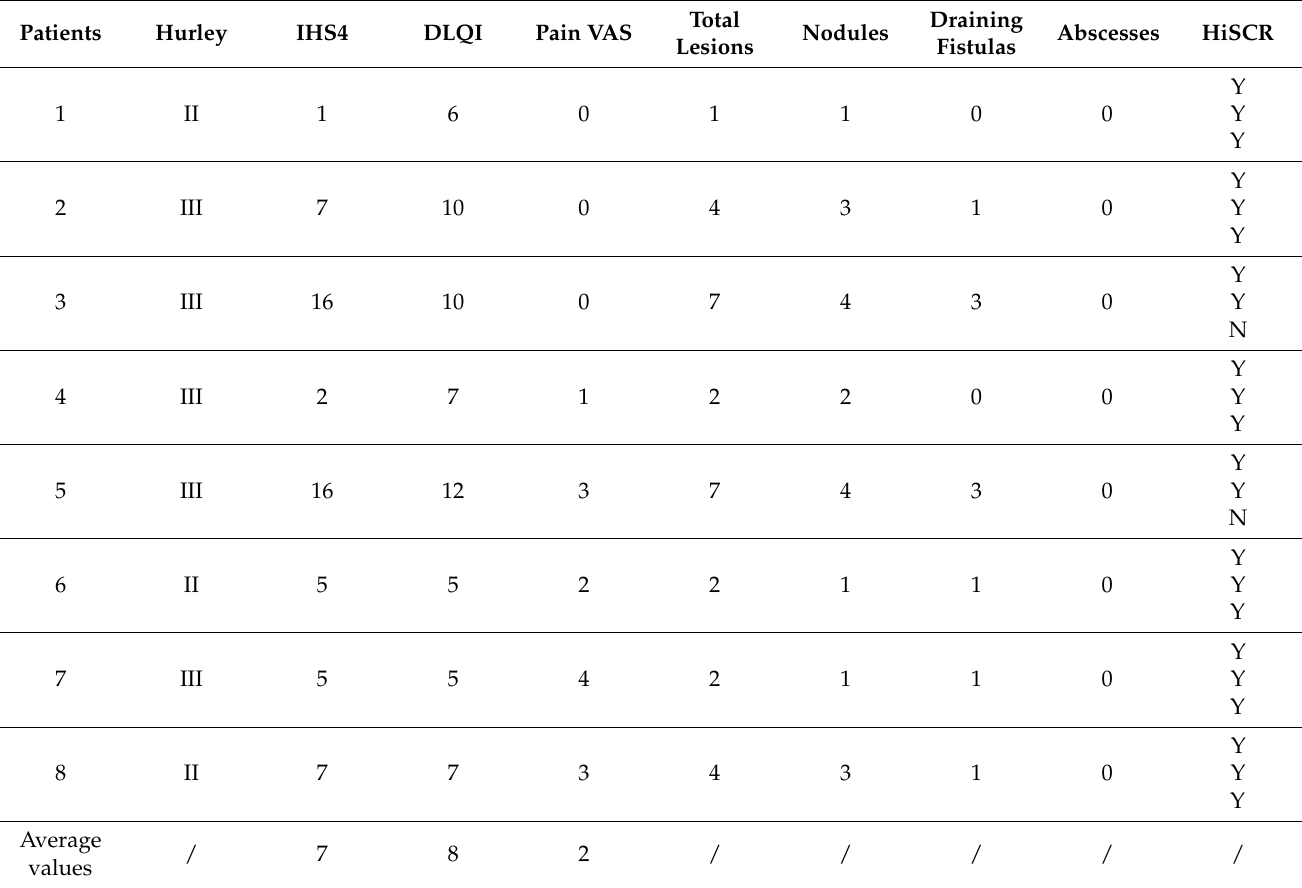
Table 3. Clinical assessment at week 12 (T12).